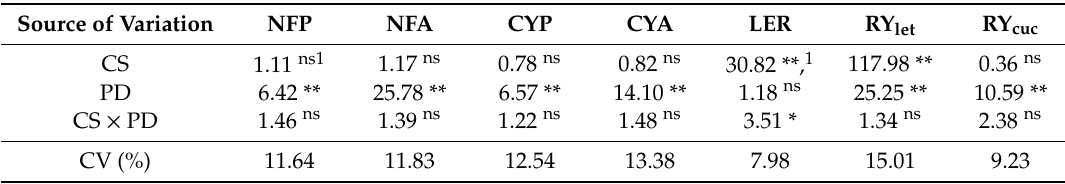
Figure 6. Cucumber yield by plant and by area as a function of population densities. ♦ kg plant − 1 ; (cid:78) kg m − 2 . ** p ≤ 0.01 in F test. Table 5. Variance analysis for number of commercial fruits per plant (NFP) and area (NFA), commercial yield per plant (CYP) and area (CYA) of ‘Soldier’ cucumber, and land equivalent ratio (LER) and relative yield (RY let and RY cuc ) according to cultivation system (CS) and population density (PD). Source of Variation